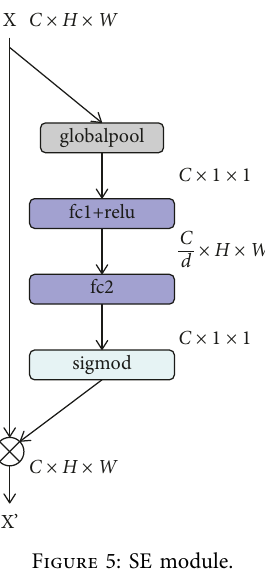
Figure 5: SE module.